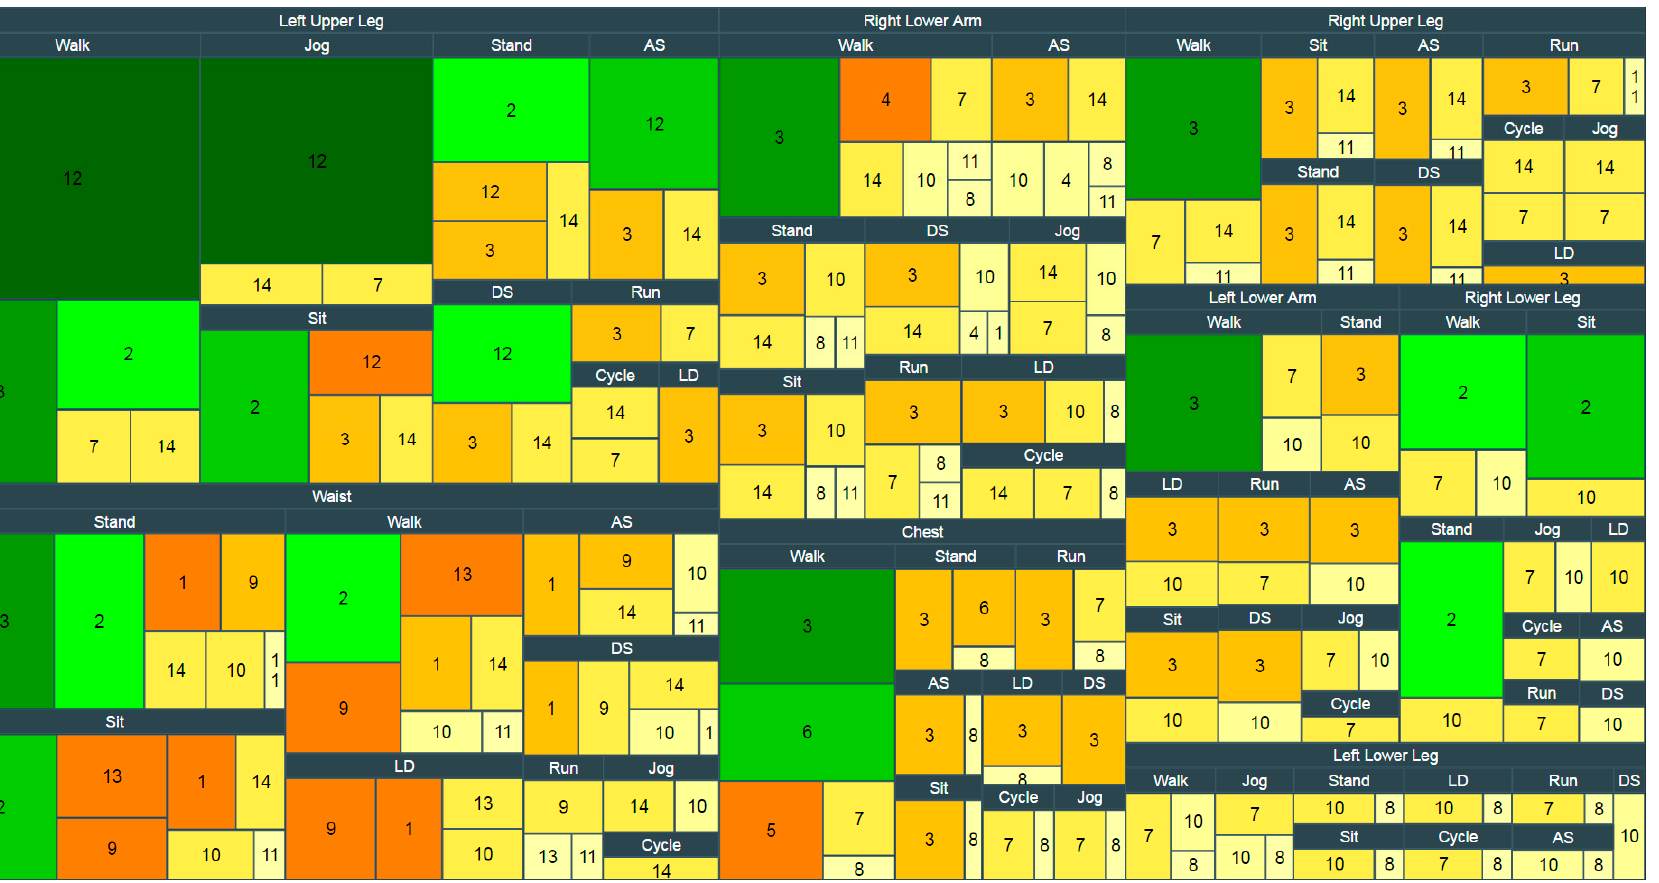
Figure 3. The rectangular tree map that presents dense volumes of data in a space filling layout to see datasets contributions in each target position. Laying Down (LD), Ascending Stairs (AS), Descending Stairs (DS). The number inside each rectangle indicates the dataset number (see first column of Table 2).